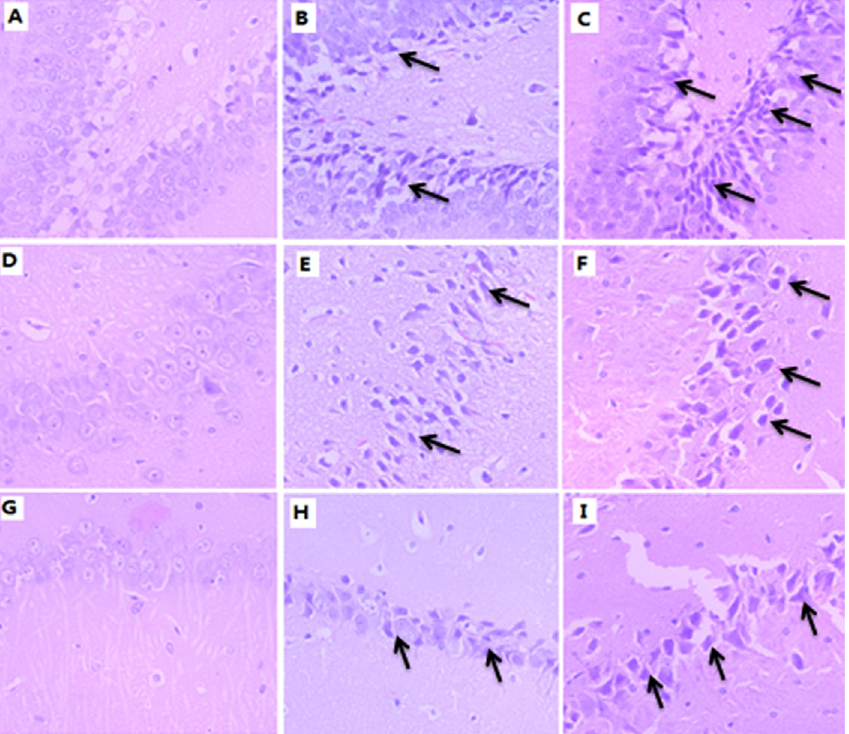
Fig 9. Representative HE staining of DG (A-C), CA3 (D-F) and CA1 regions (G-I) of the hippocampus (200 ×). The sections from control group (A, D and G), TDBP-TAZTO 5 mg/kg group (B, E and H) and 50 mg/ kg group (C, F and I). The arrows indicates neuronal nucleus shrinkage in the DG granular neurons, CA3 and CA1 pyramidal neurons. In the control group, DG granular neurons (A), CA3 and CA1 pyramidal neurons (D and G, respectively) were observed with clear round outline, well preserved cytoplasm and distinct integrated nucleus. 5 mg/kg induced mild disorganization of DG granular cell layer (B), CA3 and CA1 pyramidal cell layers (E and H, respectively) with slight neuronal damage and nucleus shrinkage, while 50 mg/kg induced moderate-severe neuronal damage and nucleus shrinkage in these areas (CA3, CA1 and DG areas in C, F and I,